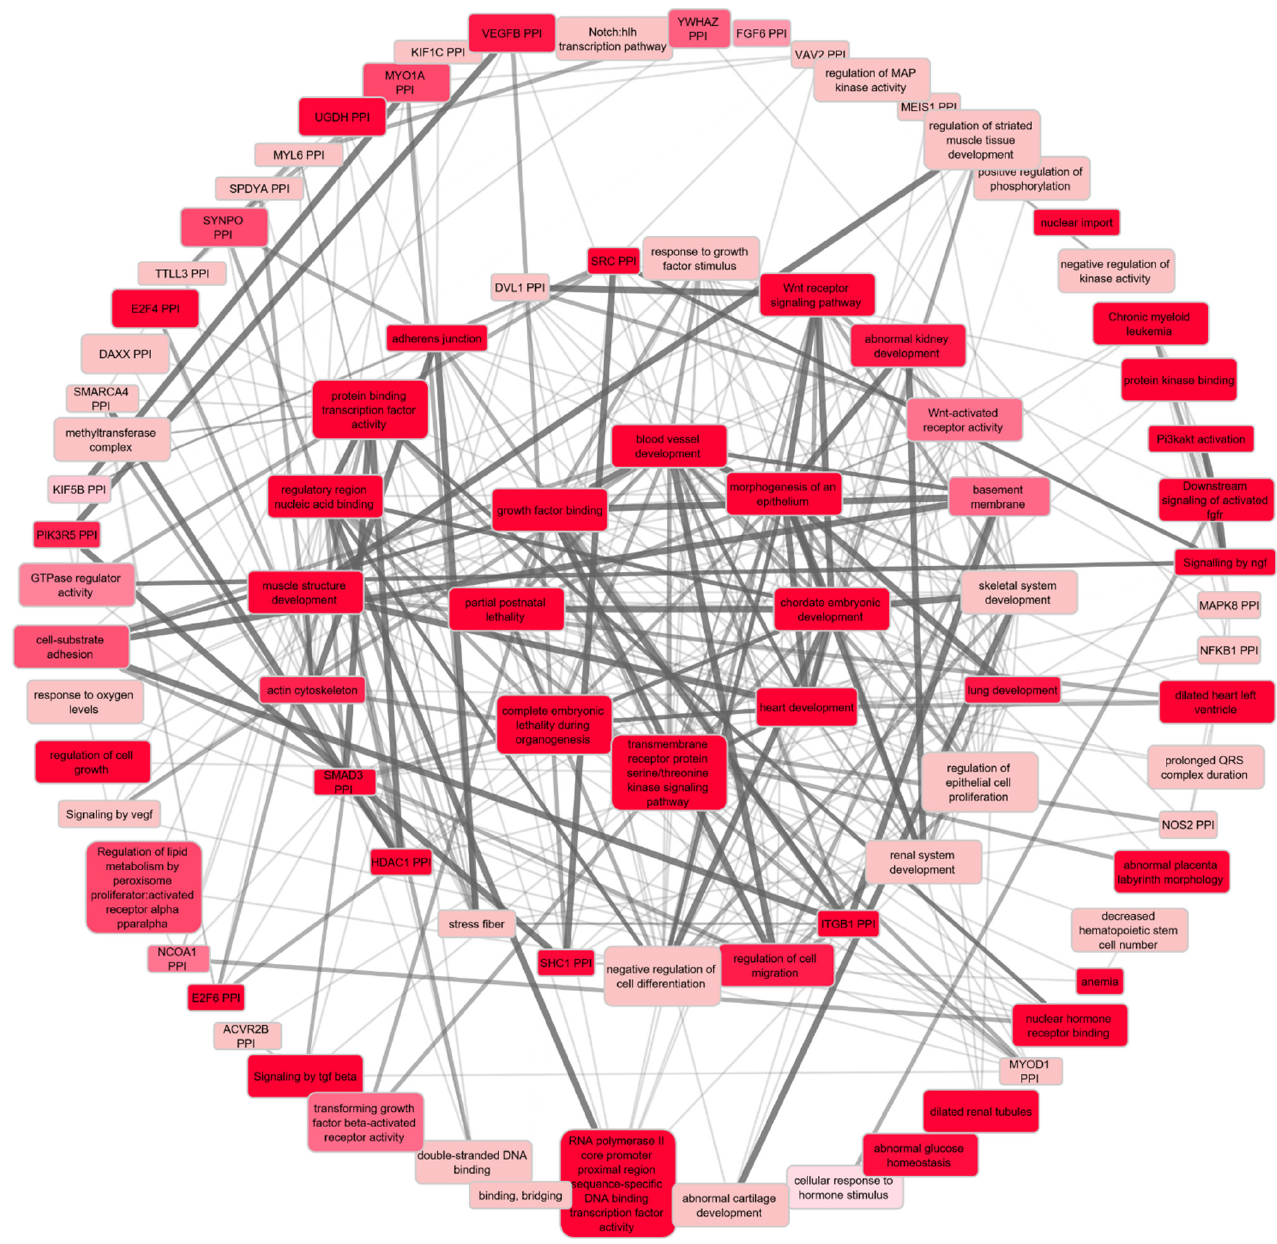
Figure 5. Network plot showing significantly enriched pathways resulting from DEPICT gene set enrichment analysis (FDR < 0.01) and clustered based on coregulation data provided by DEPICT. The outer layer contains pathways with the centrality degree ≤ 10, the middle—with the centrality degree of 10 < x ≤ 20, and the central circle contains pathways with the highest degree (>20), meaning the largest number of connections, which imply their importance in network survival. Among all, heart development has the maximum degree and the lowest p -value. Nodes are colour-coded based on the p -value.